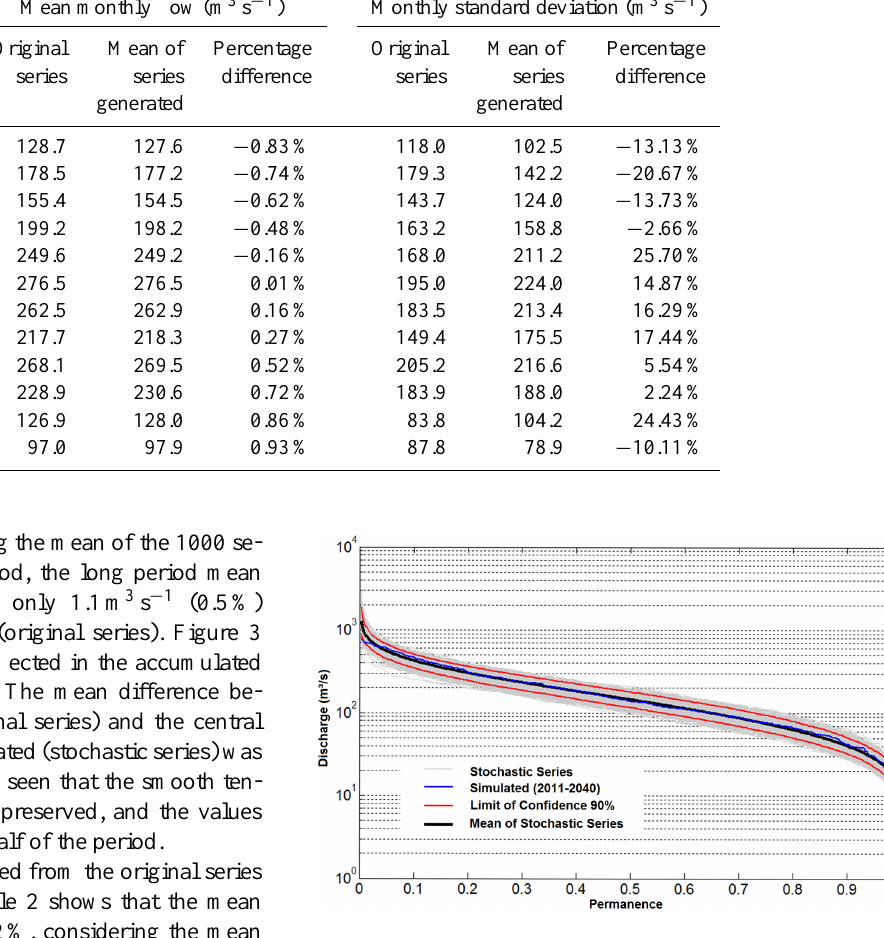
Figure 4. Permanence curves for the mean monthly flow between 2011 and 2040 – difference between the original series (simulated) and the 1000 stochastic series generated – Santo Ângelo gauge sta-